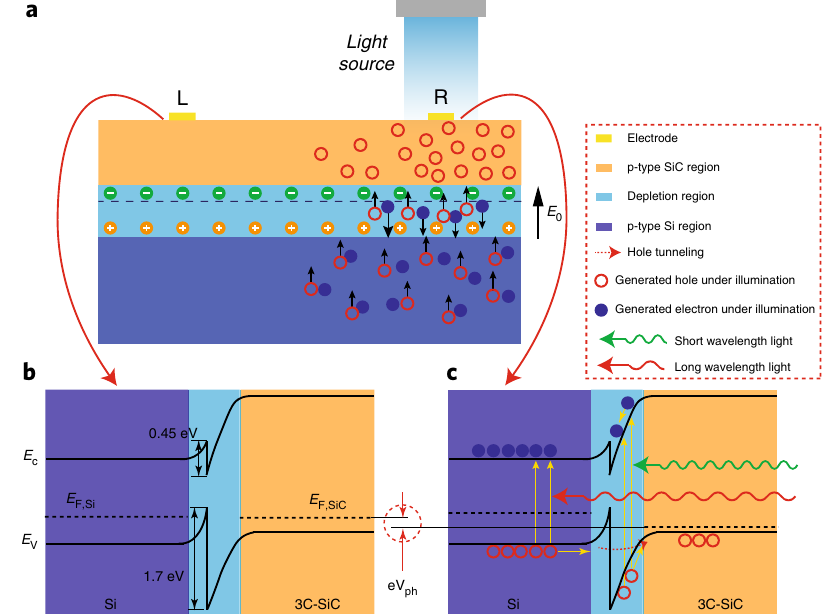
Fig. 5 Formation mechanism of the lateral photovoltage. a Electron – hole pair generation and separation. Under visible light, electron – hole pairs are generated in the depletion region and Si substrate. Then, the generated EHPs in the depletion region are separated by an internal electric fi eld, and the generated holes in the Si substrate tunnel to the 3C-SiC thin fi lm. Schematic band diagrams of the heterojunction at the electrode L area without illumination b and at the electrode R area with illumination c . Under non-uniform illumination, photons are injected into the electrode R area rather than into the electrode L area, resulting in holes generated and injected in this area. Consequently, there is a gradient of the hole concentration in the 3C- SiC